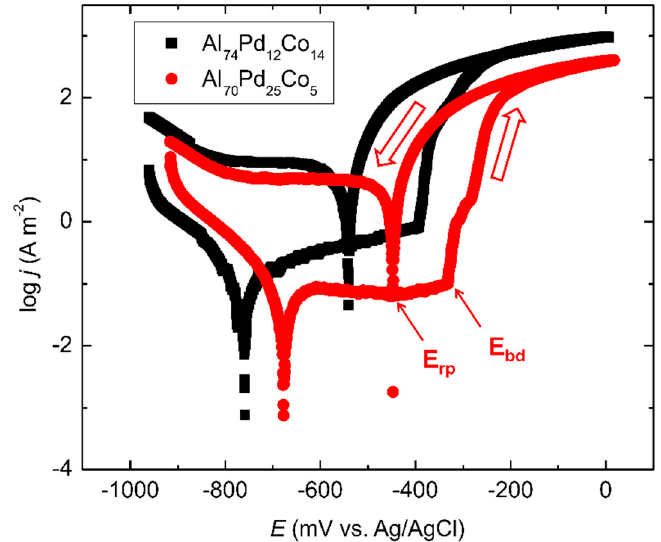
Figure 8. Cyclic potentiodynamic polarization curves of the as-solidified Al 74 Pd 12 Co 14 and Al 70 Pd 25 Co 5 alloys in 0.6 M NaCl. The polarization direction and positions of breakdown (E bd ) and re-passivation potentials (E rp ) are indicated by arrows. For the color interpretation of this figure, the reader is referred to the web version of this article. Table 3. Electrochemical parameters of as-solidified Al 70 Pd 25 Co 5 and Al 74 Pd 12 Co 14 alloys. Corrosion potentials (E corr ) and corrosion current densities (j corr ) were obtained by Tafel extrapolation of forward curves (Figure 8).